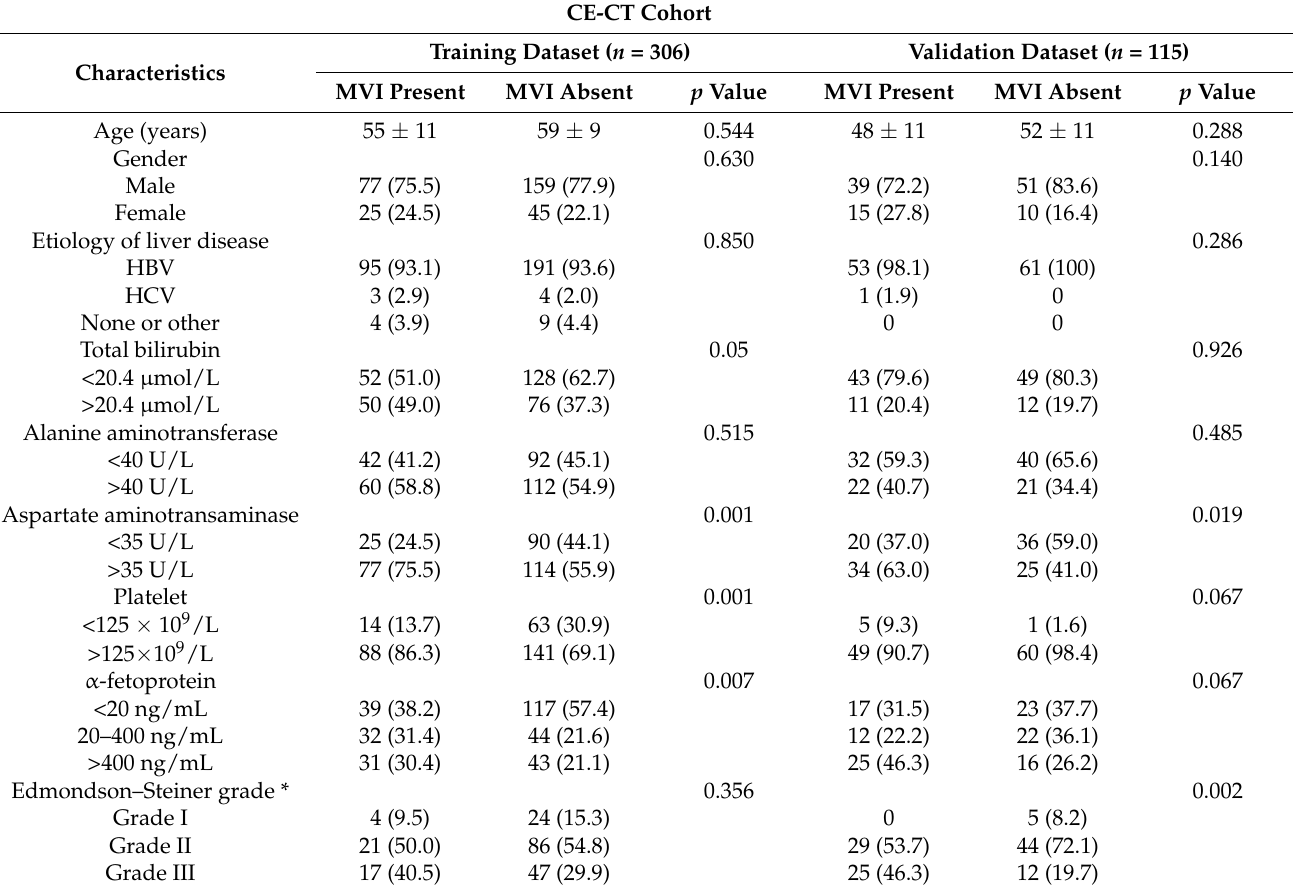
Table 2. Baseline characteristics of enrolled